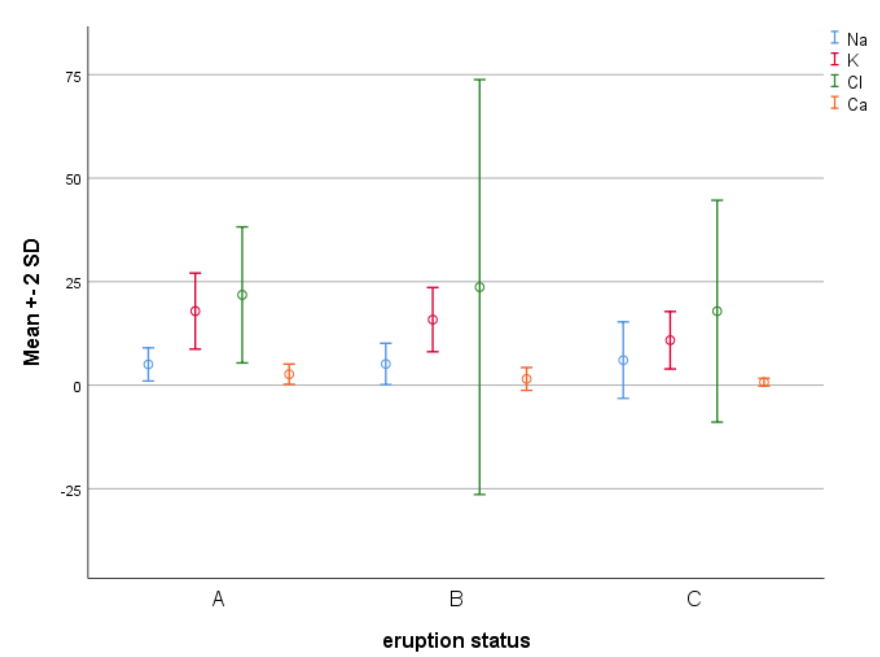
Figure 2. Means ± SD concentrations of sodium, potassium, chloride, and calcium ions in the three groups. three